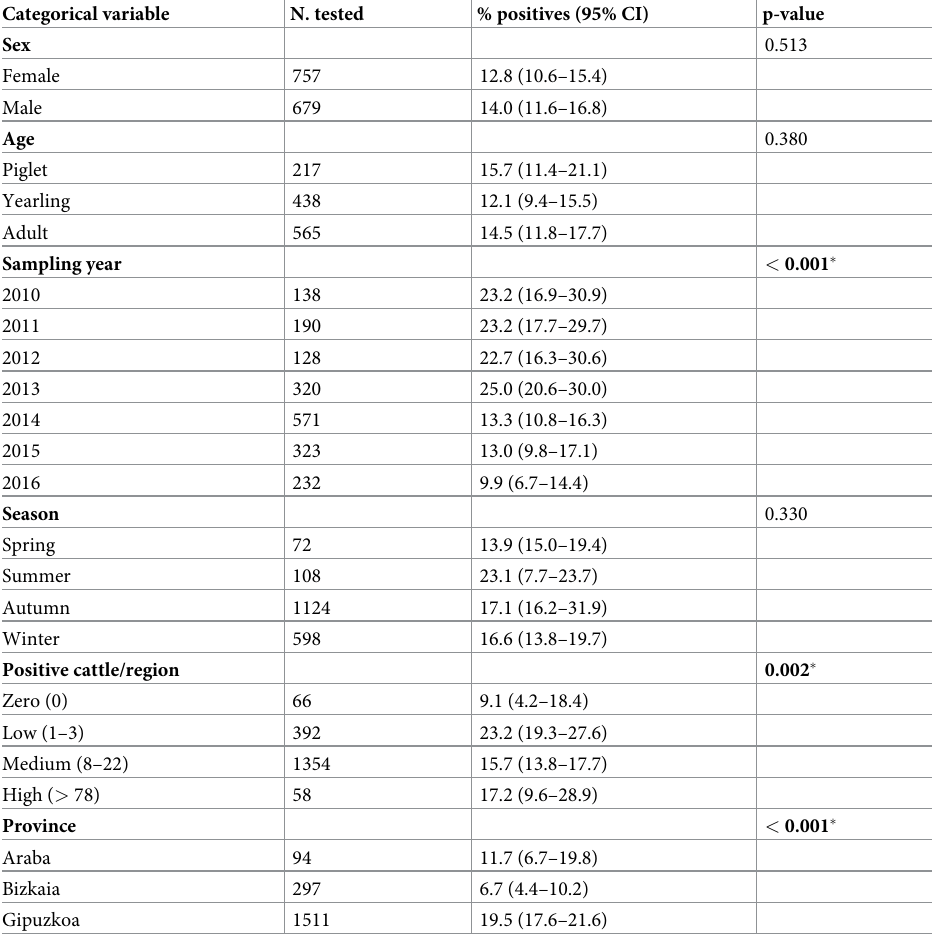
Table 1. Seroprevalence of MTC detected in wild boars according to categorical